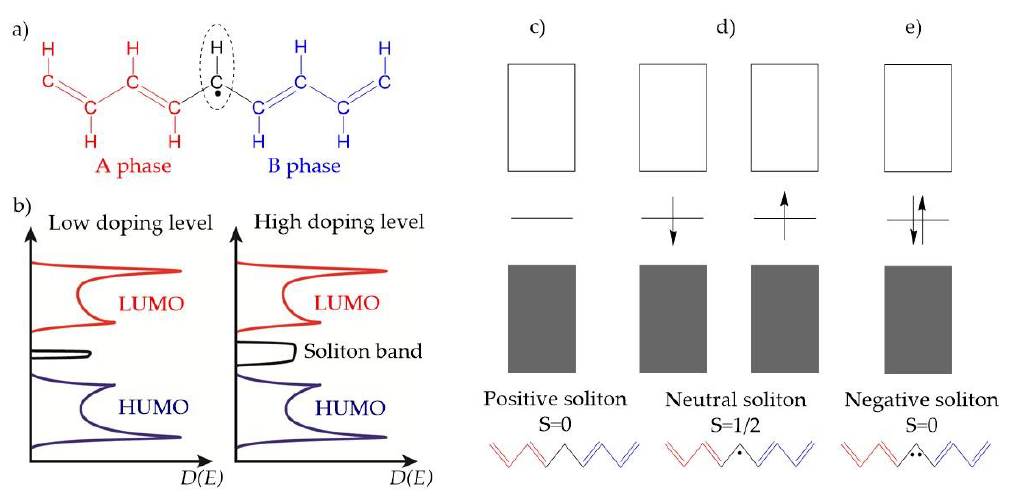
Figure 4. ( a ) Schematic illustration of the geometric structure of a neutral soliton on a trans-polyacetylene chain; ( b ) A soliton band with light doping (left) and heavy doping (right); The band structure of trans-polyacetylene containing ( c ) a positively charged soliton; ( d ) a neutral soliton; and ( e ) a negatively charged soliton .